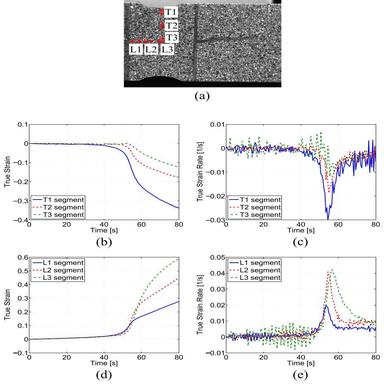
True strain and strain rate of line segments.